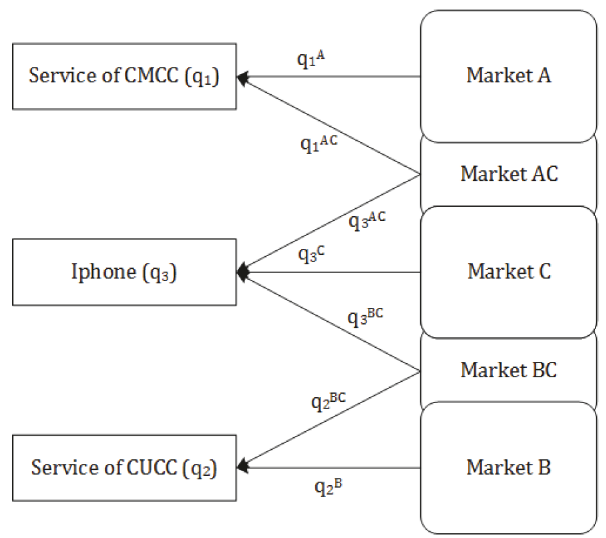
Figure 1: The structure of the